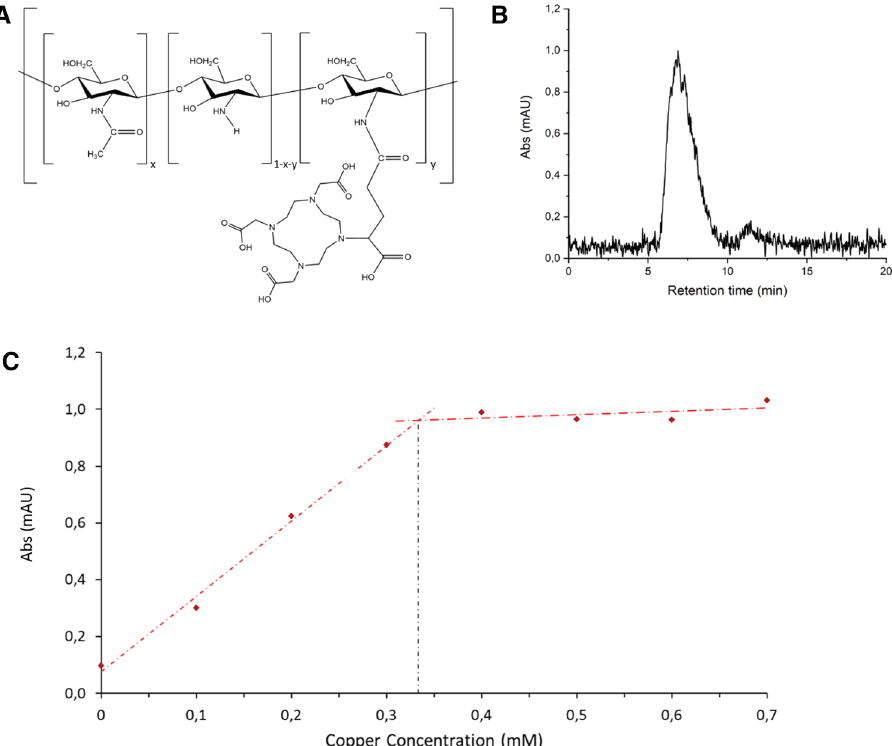
Figure 2. ( A ) Representation of reacetylated chitosan functionalized by DOTAGA: Chitosan@DOTAGA (x corresponds to acetylation ratio and y to DOTAGA grafted ratio). ( B ) SEC HPLC/UV elution diagram of Chitosan@DOTAGA in aqueous medium in absence of Cu(II) using detection at 295 nm (milli absorption units). ( C ) Dosage of a solution of 1 g L −1 of Chitosan@DOTAGA by Cu(II) using HPLC–UV SEC and plotting peak at 6.7